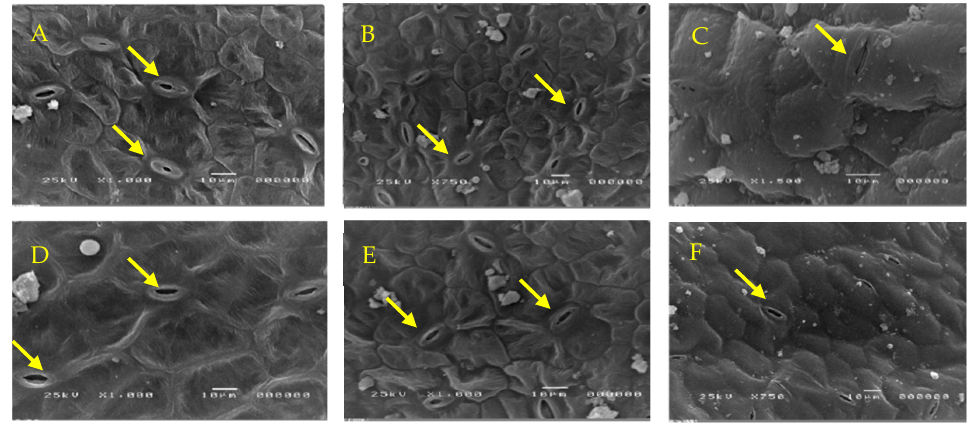
Figure 6. Scanning electron microscopy for stomatal closure of cucumber leaves grown under 2 PEG-6000 levels (5 and 10%) 15 days post P. indica co-cultivation. ( A ) No-stress, ( B ) 5% PEG-6000, ( C ) 10% PEG-6000, ( D ) P. indica- colonized plants, ( E ) P. indica + 5% PEG-6000, ( F ) P. indica + 10% PEG-6000. Scale bar = 10 μm.